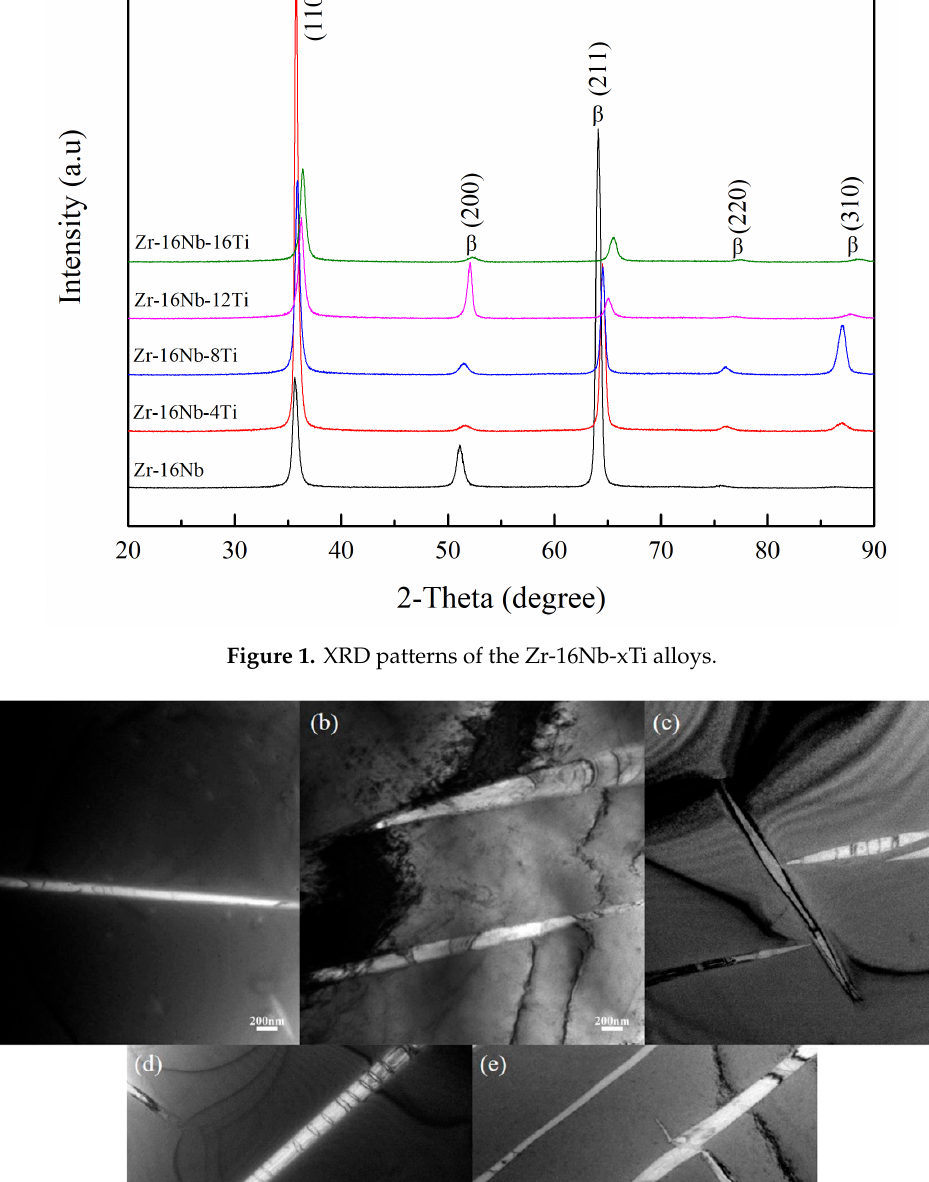
Figure 2. Dark-field TEM images of the martensite phase morphology of the Zr-16Nb-xTi alloys based on different areas: ( a ) Zr-16Nb; ( b ) Zr-16Nb-4Ti; ( c ) Zr-16Nb-8Ti; ( d ) Zr-16Nb-12Ti; ( e ) Zr-16Nb-16Ti.